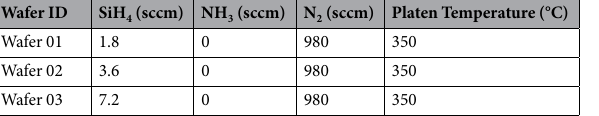
Table 5. PECVD deposition parameters for the three different wafer composition employed in this